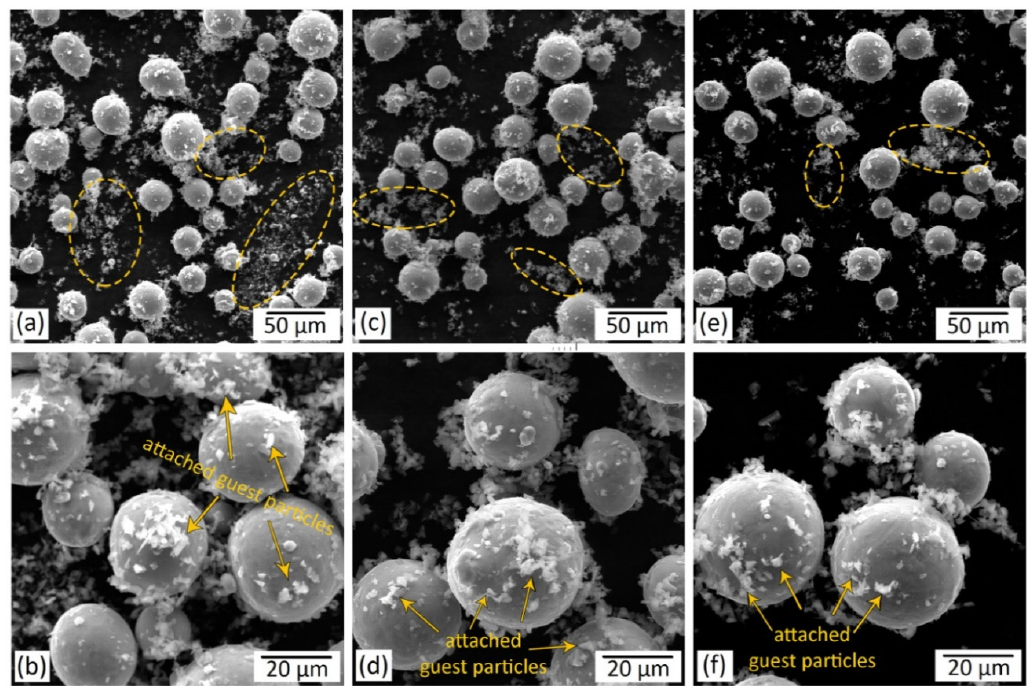
Figure 4. SEM micrographs of 5 wt.% B 4 C / Ti-6Al-4V mixed powder systems subjected to regular mixing for: ( a , b ) 1 h (R1); ( c , d ) 3 h (R3); and ( e , f ) 6 h (R6). The ellipses in ( a , c , e ) indicate the free B 4 C (guest) particles that are not attached to the Ti-6Al-4V (host) particles and are agglomerated.